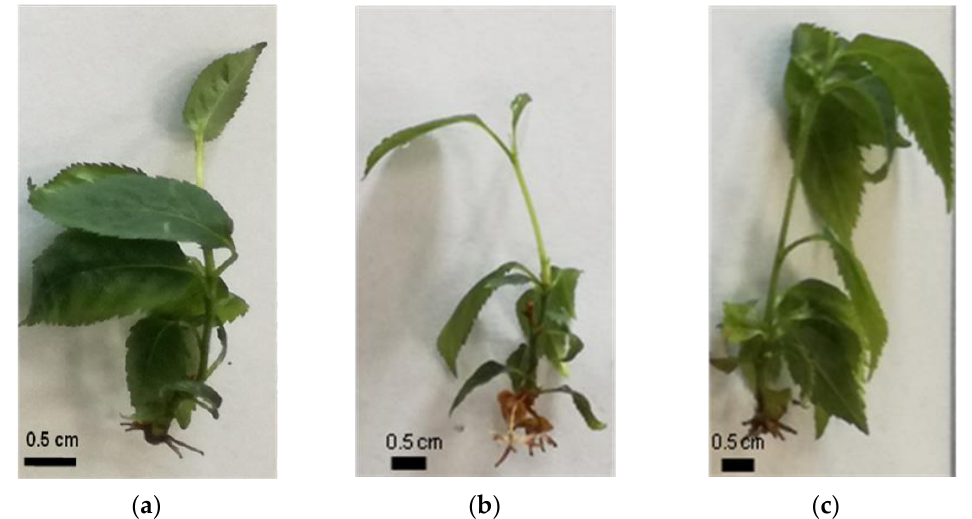
Figure 2. Rooted explants by the effect of ( a ) dopamine; ( b ) 5-hydroxy-1,4-naphthoquinone; and ( c ) chlorogenic acid cultivated in rooting medium in the presence of IBA. Table 3. Effect of 1,4-napthoquinone; 2-hydroxy-1,4-naphthoquinone; and p-benzoquinone on rooting variables of explants cultivated in rooting medium in the presence of